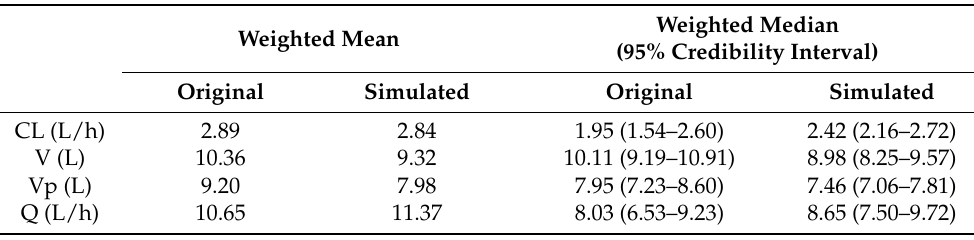
Table 1. Weighted mean and weighted median (95% credibility interval) of the population pharma- cokinetic model parameters support points for the original and simulated dataset.